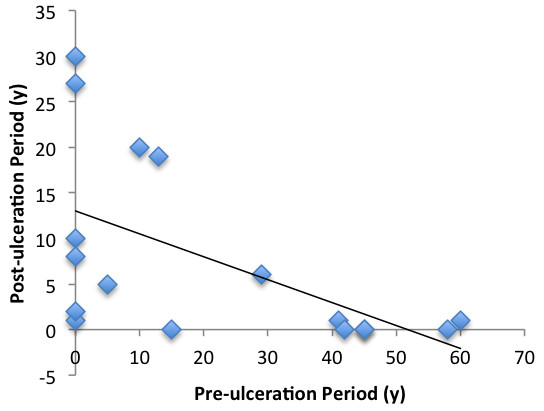
Relationship between the pre- and post-ulceration periods.